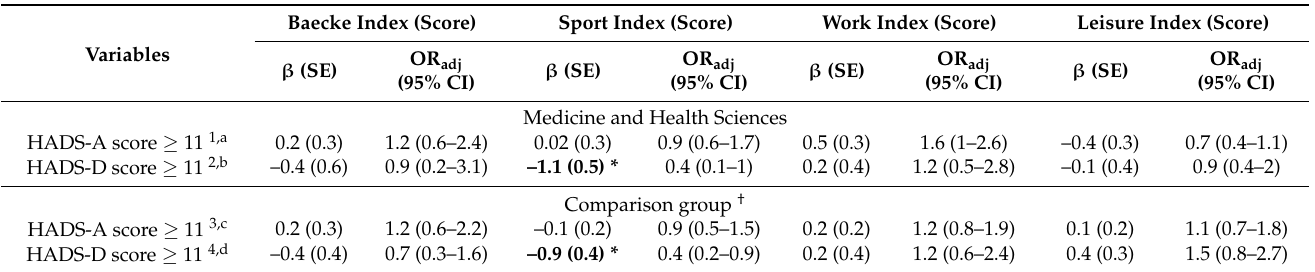
Table 4. Logistic regression analyses with symptoms of anxiety and depression (HADS-A and HADS-D) as dependent